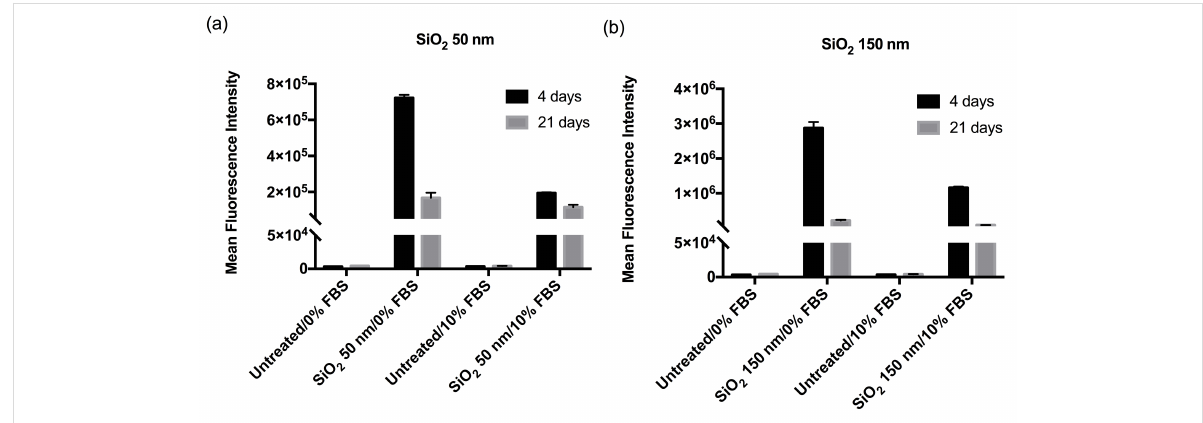
Figure 1: 50 nm and 150 nm SiO 2 -NP association with Caco-2 barriers. Caco-2 barriers cultured for 4 and 21 days were exposed for 6 h to (a) 50 nm and (b) 150 nm SiO 2 -NPs (100 µg/mL) in the absence and presence of 10% serum, prior to cell fluorescence measurements by flow cytometry. Results are presented as the mean cell fluorescence intensity (due to nanoparticles) with error bars representing the standard error of the mean of 3 technical replicates (Supporting Information File 1, Figure S8 shows a comparison of three independent experiments). One may observe a general trend of a larger nanoparticle association to barriers cultured for 4 days compared to those cultured for 21 days, as well as a trend of larger associa- tion in the absence of serum. Note that the two nanoparticles are loaded with different amounts of fluorescent dye so no (direct) absolute comparison may be made between the two